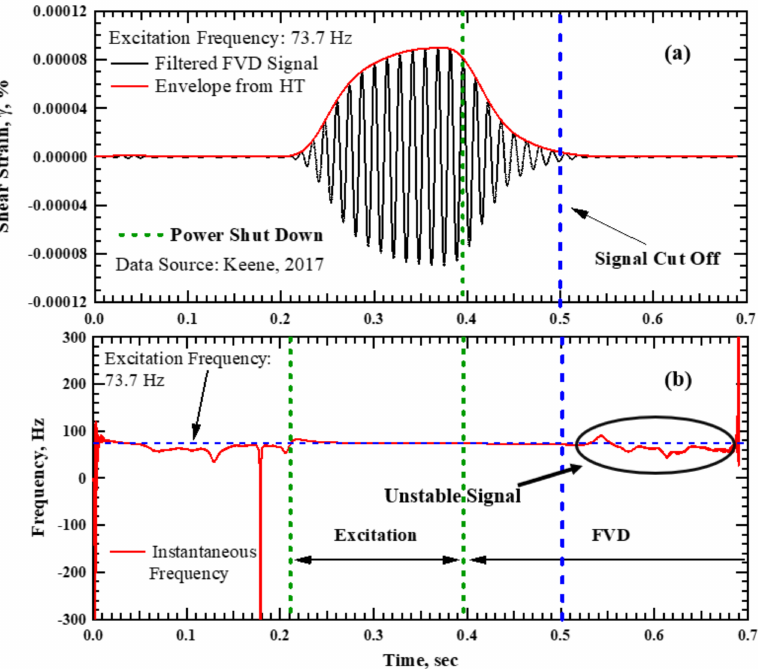
Figure 16. ( a ) The Hilbert Transform and ( b ) the instantaneous frequency over time of a clay